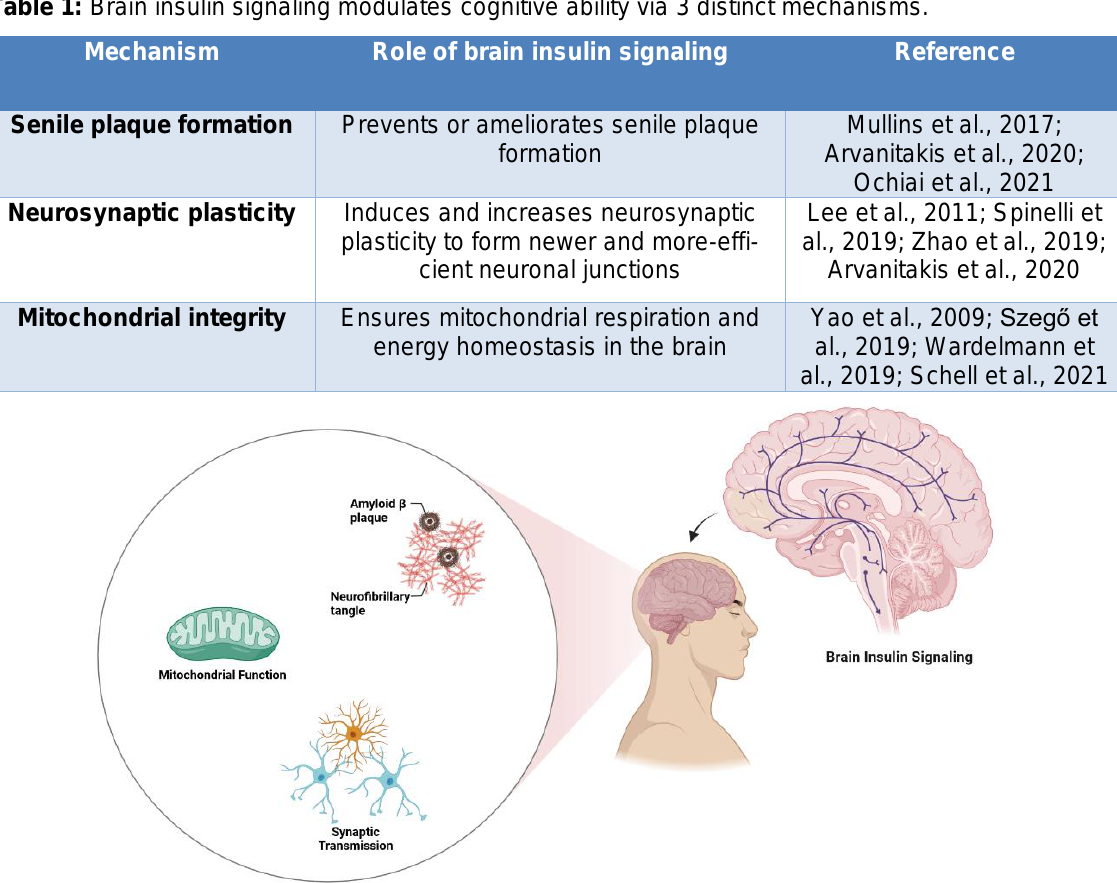
Figure 2: Brain insulin signaling is involved in cognitive function via at least three pathways: modulating senile plaque formation, synaptic transmission and mitochondrial efficiency in the